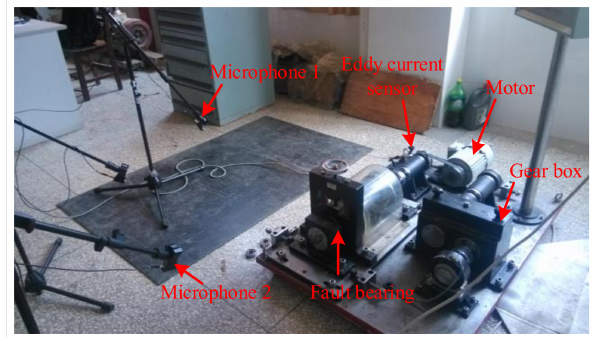
Figure 11. The layout of the test bench and